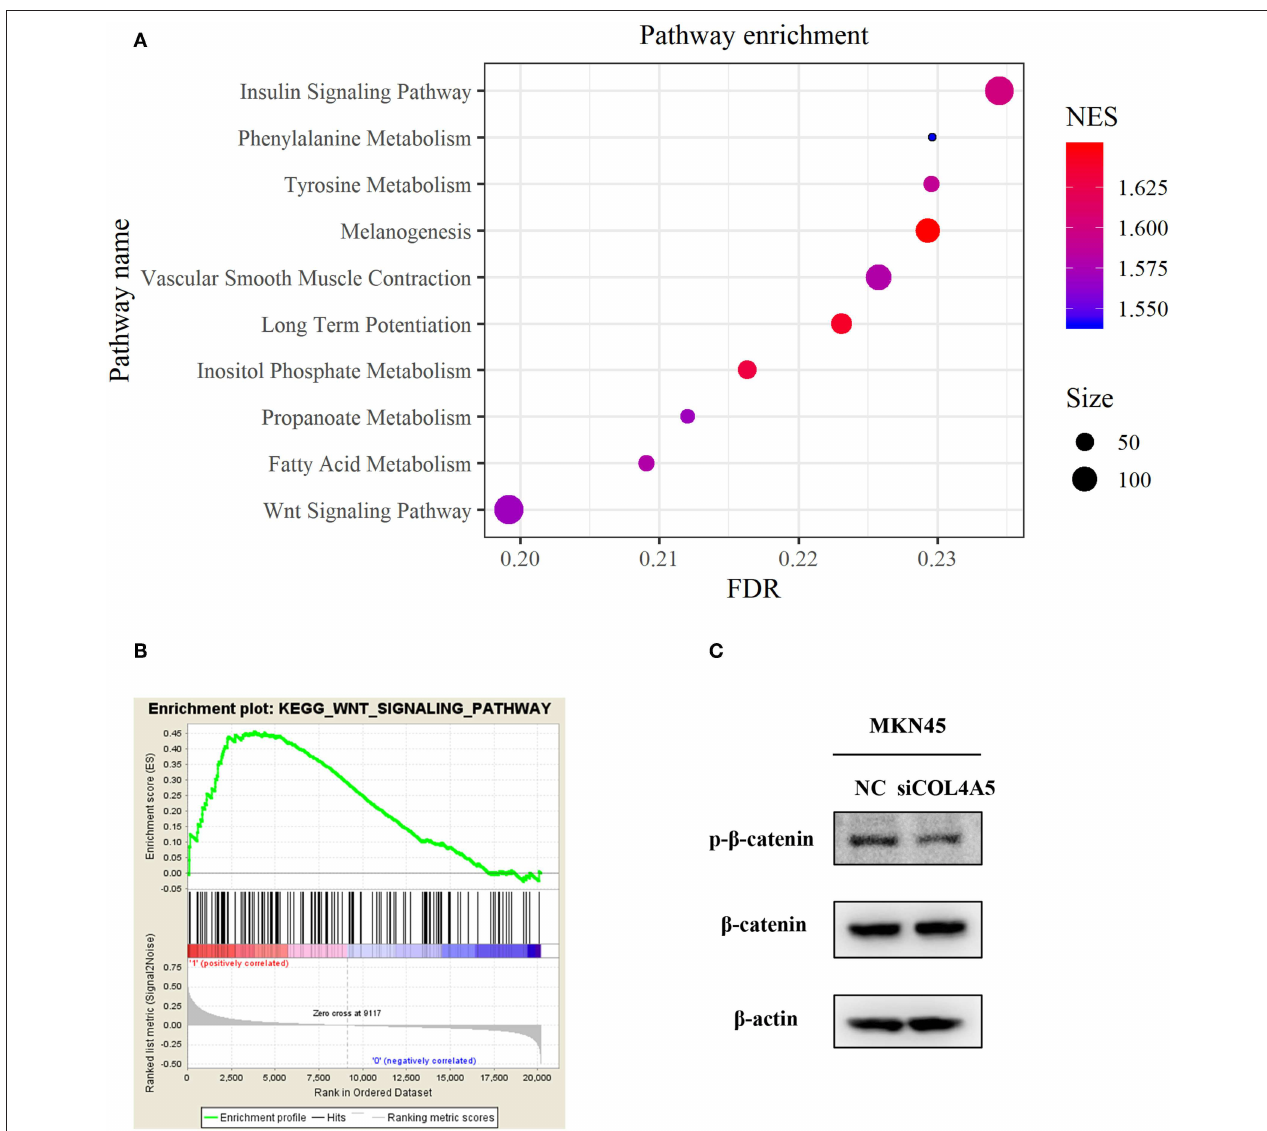
FIGURE 6 | Functional enrichment analysis of COL4A5 in diffuse type GC. KEGG (A) and GSEA (B) analysis were used to analyze COL4A5 high expression group enriched signaling pathways. The expression of p- β -catenin and β -catenin was detected by western blot after transient knockdown of COL4A5. β -actin was used as internal control (C)